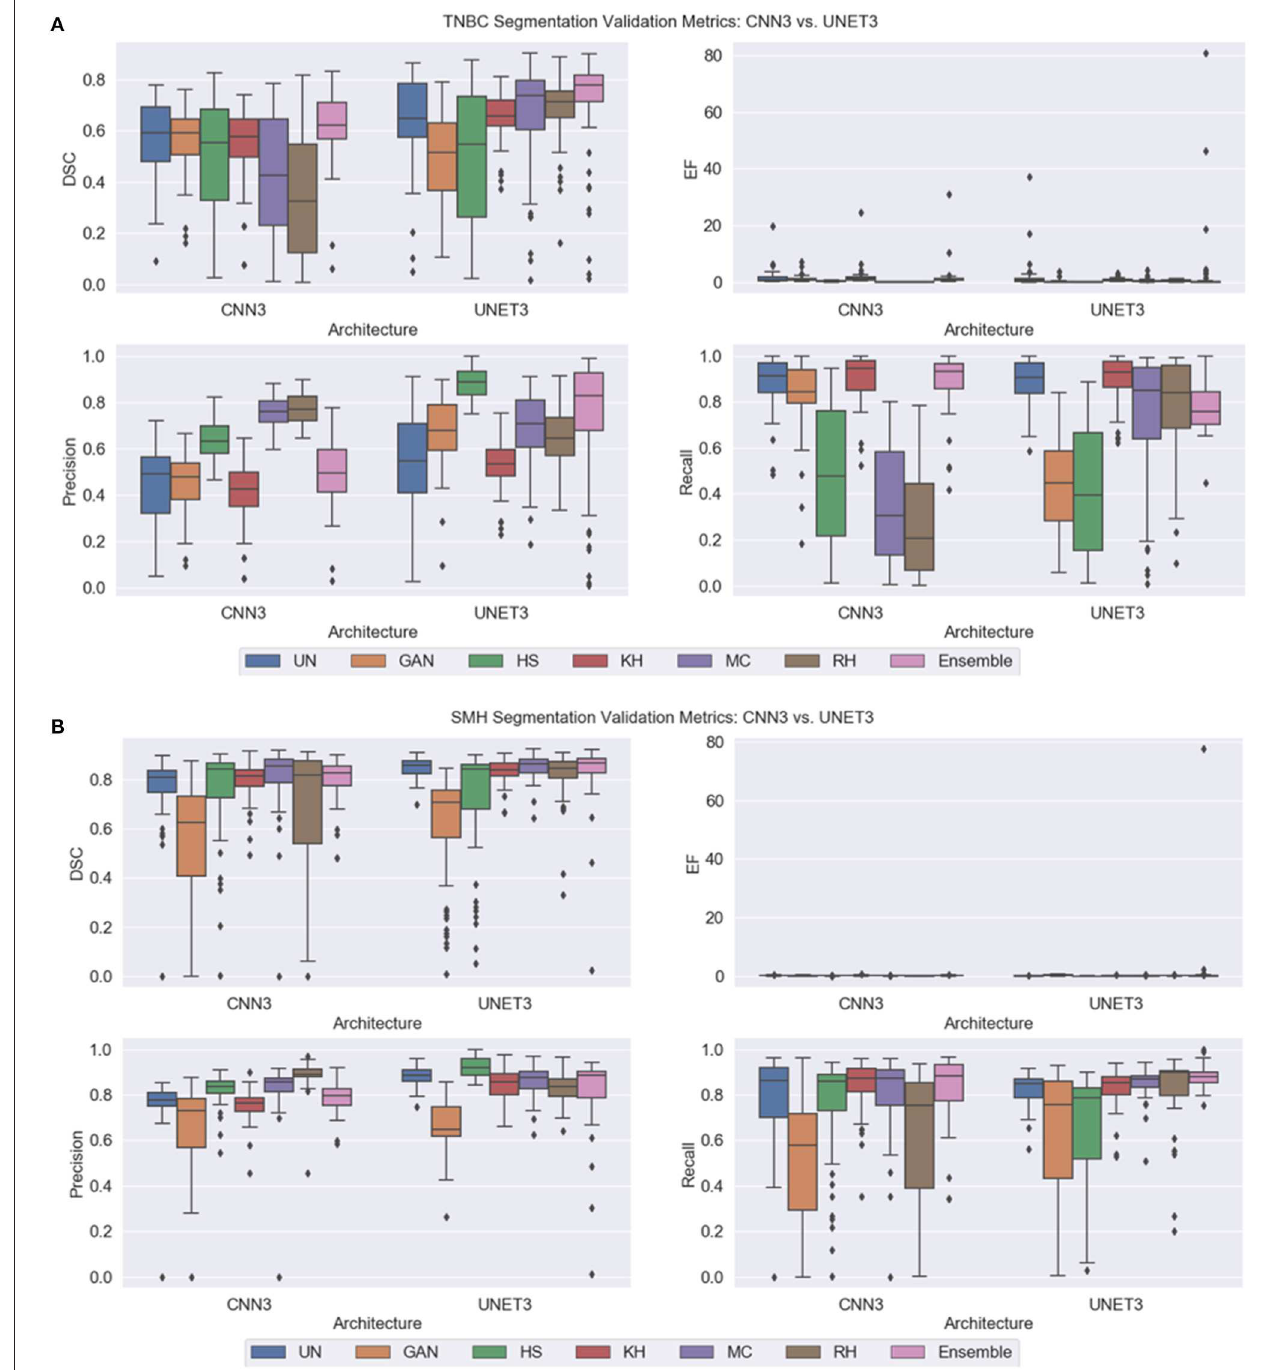
FIGURE 10 | Segmentation validation metrics on new data. (A) TNBC dataset (B) SMH-seg dataset.